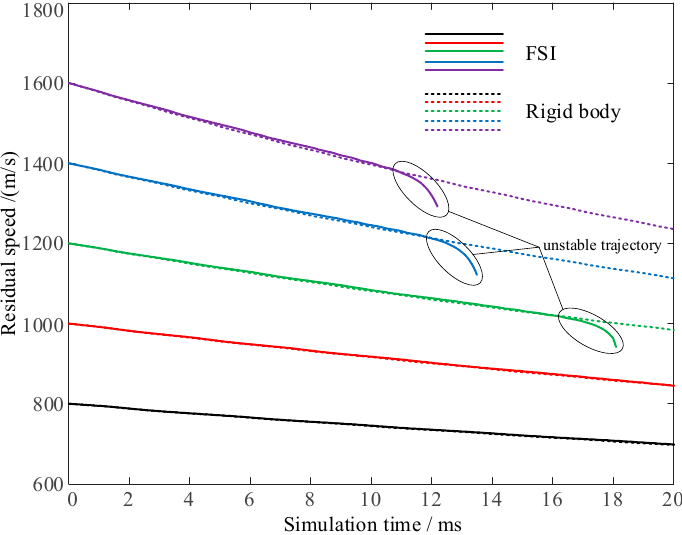
Figure 15. Change of speed of elastic and rigid supercavitating projectiles.